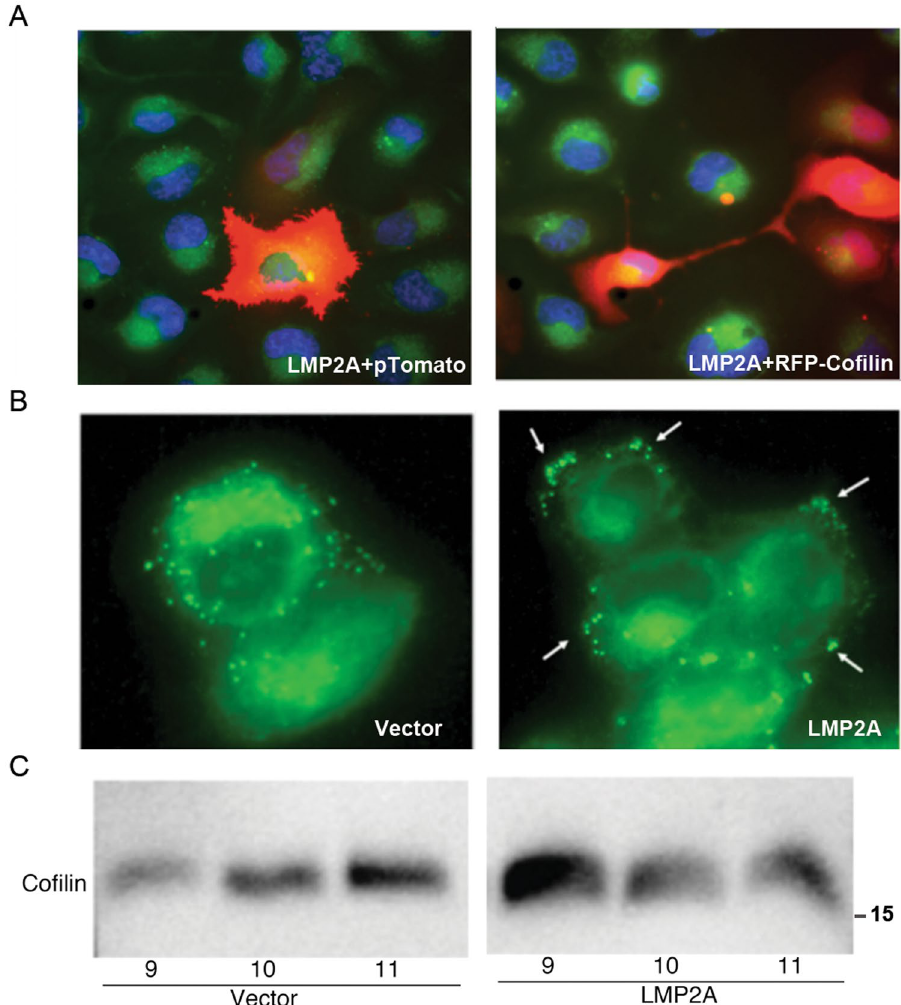
Figure 4. LMP2A facilitates cofilin accumulation at the cellular periphery. Fluorescence analysis of cofilin expression. Panel A CNE2 cells transiently transfected with LMP2A, together with a plasmid coding for the fluorescent protein pTomato (left panel). CNE2 cells transiently transfected with LMP2A, together with a plasmid, coding for RFP-cofilin (right panel). ( B ) LMP2A induced accumulation of lipid droplets in CNE2 NPC cells. Specific distribution at the periphery of the cells is indicated with arrows. Fluorescence analysis with the neutral lipid specific fluorescent dye Bodipy 495/503 in cells transfected with vector control (left panel) or with an LMP2A construct (right panel). ( C ) WB analysis of cofilin distribution after ultracentrifugation in a discontinuous Optiprep gradient. Fractions are numbered from the